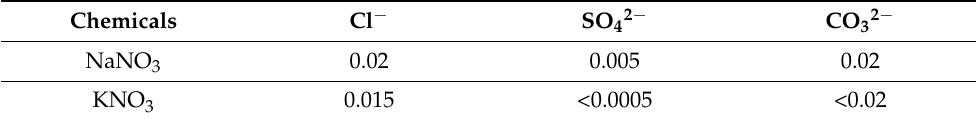
Table 1. Impurities composition in the chemicals used.